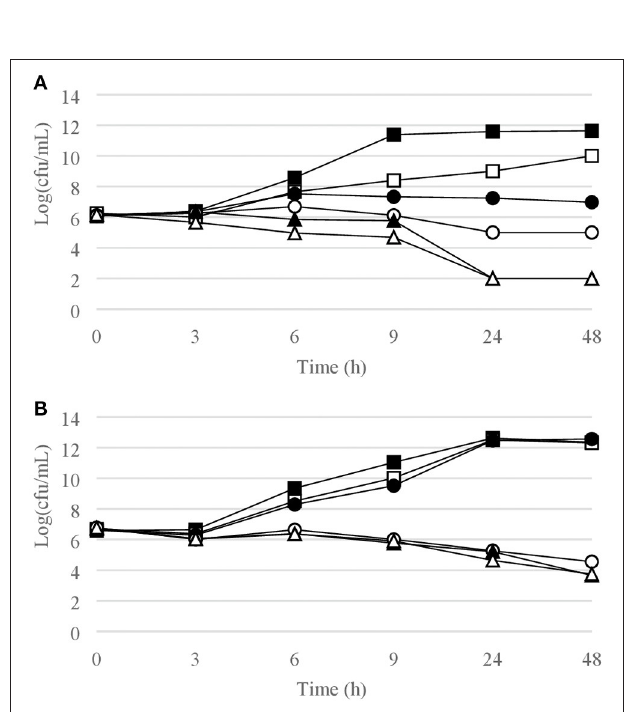
FIGURE 4 | Time-kill curves for P. acnes . (A) chlorquinaldol; (B) fusidic acid. Filled square, control; open square, ¼ × MIC; filled circle, ½ × MIC; open circle, 1 × MIC; filled triangle, 2 × MIC; open triangle, 4 × MIC.